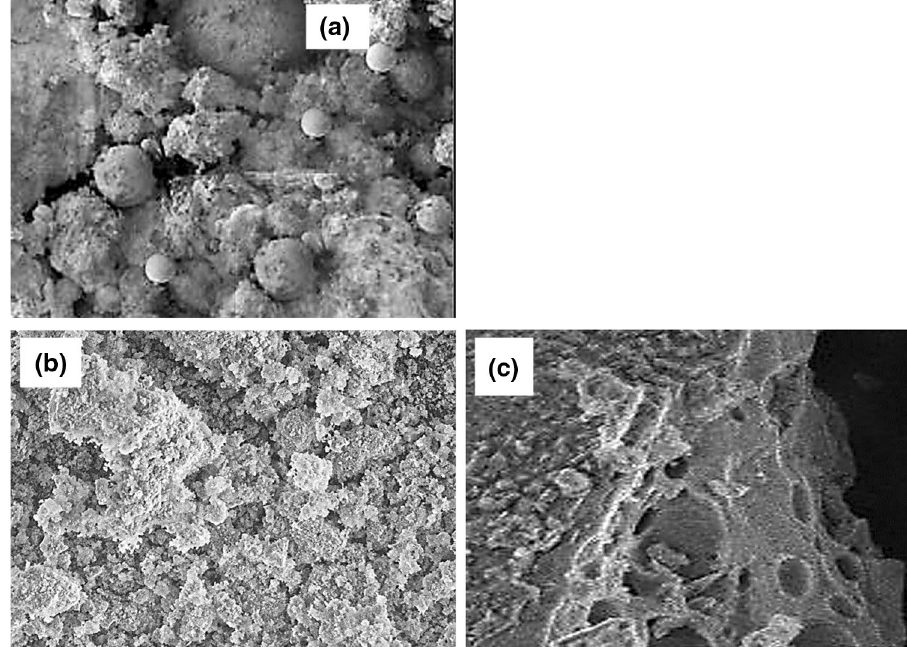
Fig. 8 SEM micrographs of a BFA, b MgFZBFA, c MgMZ- BFA showing their morpholo-